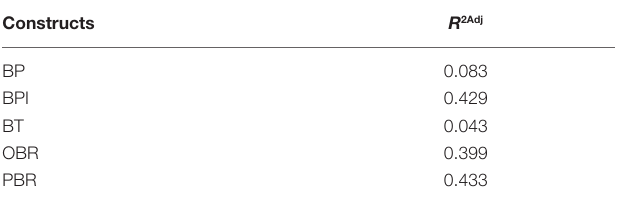
TABLE 6 | Adjusted R 2